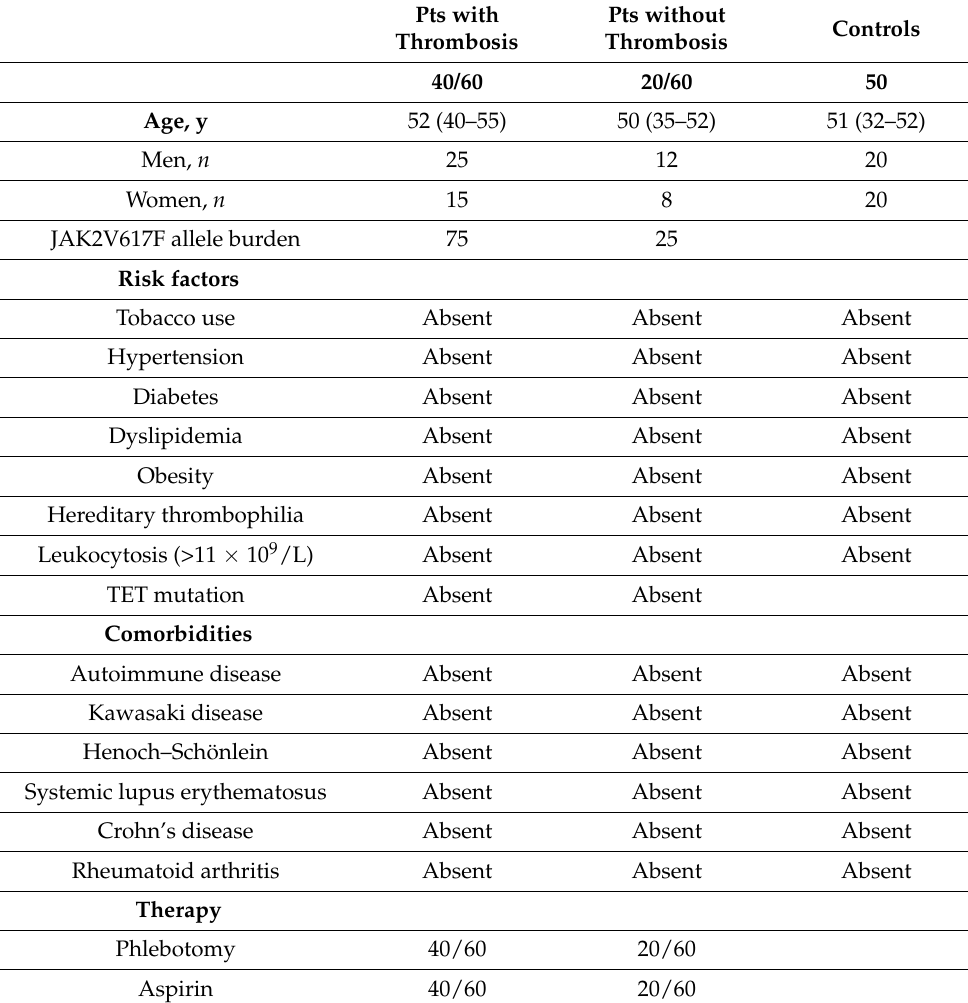
Table 1. Characteristics of the 60 patients with polycythemia vera and the controls. Pts